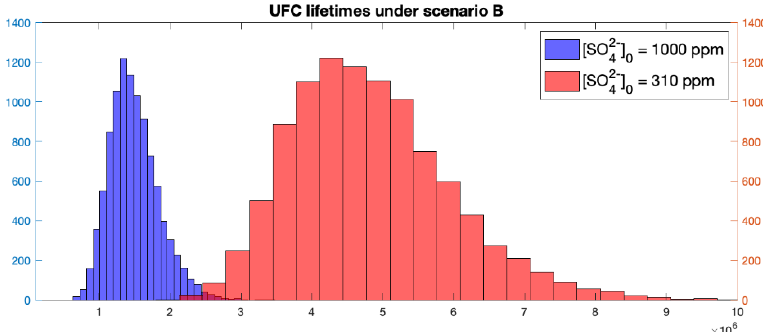
Figure 5. Histogram of UFC lifetimes under scenario